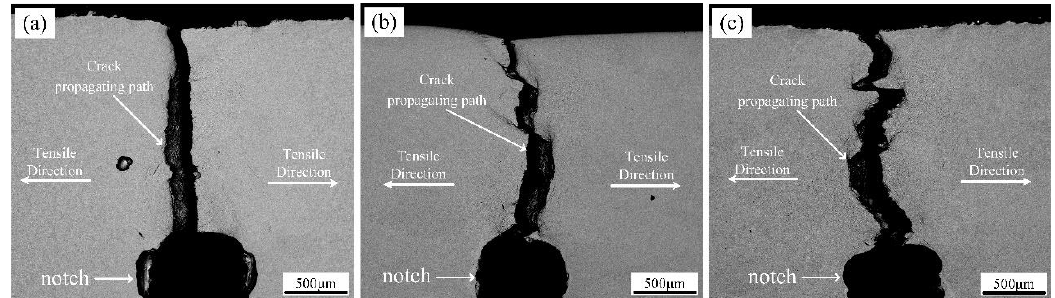
Figure 9. Fracture paths of the joints welded at ( a ) E = 2.2 × 10 3 J/cm; ( b ) E = 3.4 × 10 3 J/cm; and ( c ) E = 5.5 × 10 3 J/cm.